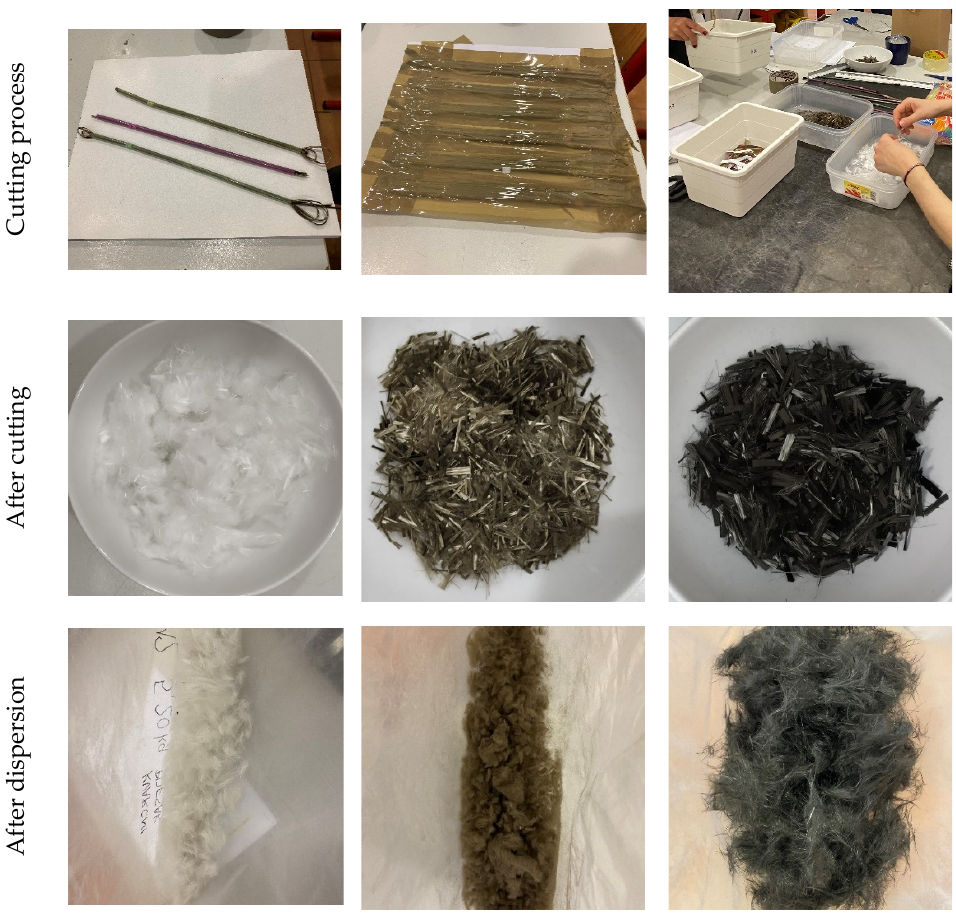
Figure 1. Visual appearance of the waste fibres used, from left to right: AR-glass, basalt and carbon fibres.